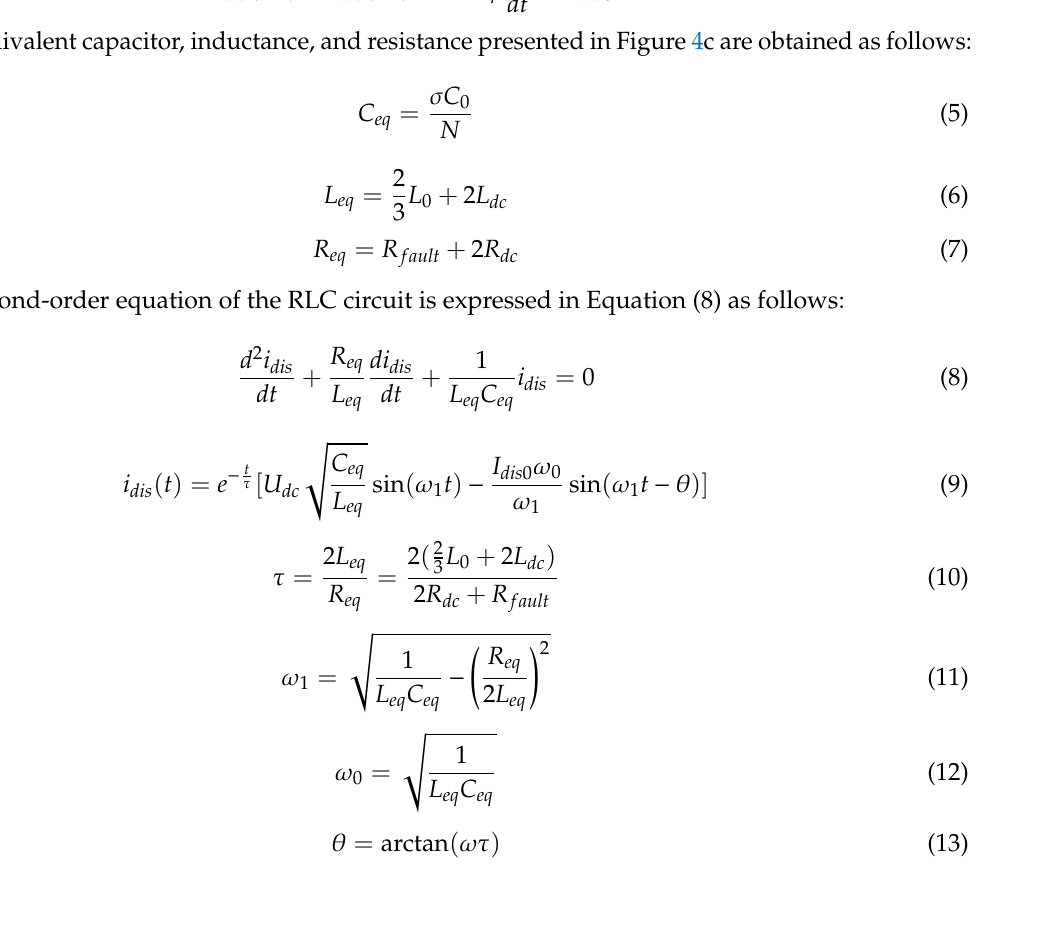
Figure 5. Relationship between discharging coefficient and fault time (m = 0.93).